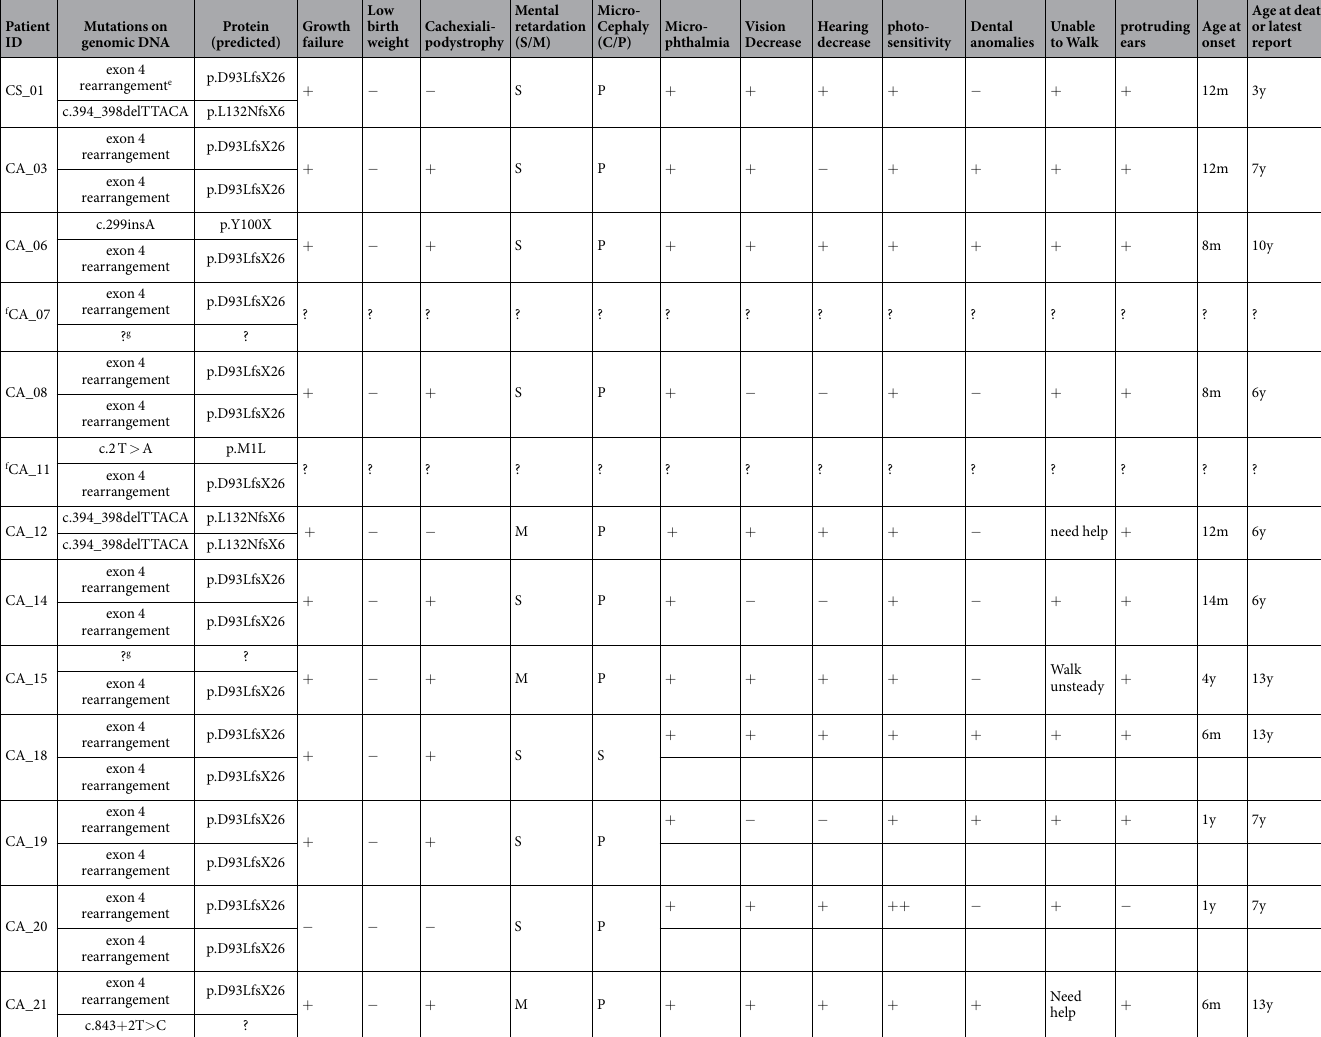
Mental retardation (S/M)